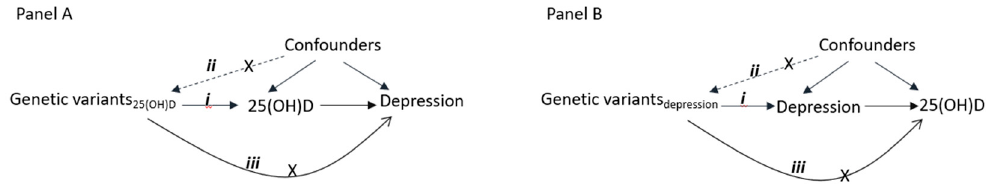
Figure 1. Diagram showing the principle of Mendelian randomization (MR) analysis [15]. Panel A shows the association between 25(OH) and depression, and Panel B between depression and 25(OH)D. The numbers reflect the MR assumptions that the genetic variants should (i) be associated with the exposure, (ii) not associated with the confounders of exposure-outcome association, and (iii) not affect the outcome through pathways other than exposure.